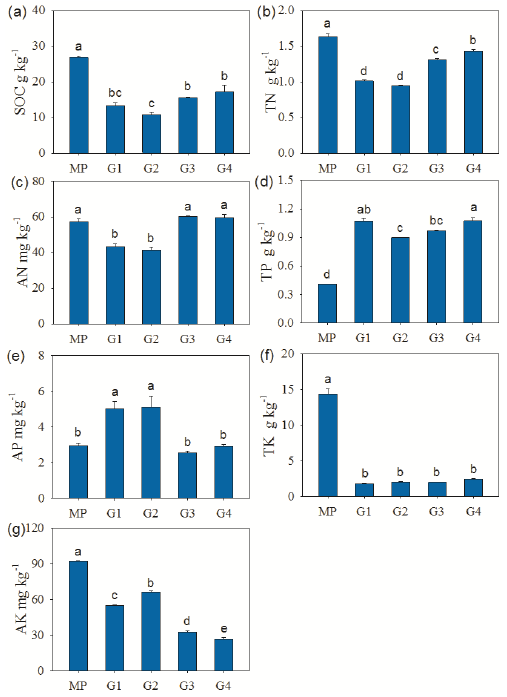
Figure 2. Soil chemical properties in the Pinus and the successive Eucalyptus plantations. MP, G1, G2, G3 and G4 refer to the Pinus plantation and the first, second, third and fourth generation Euca- lyptus plantations, respectively. SOC, soil organic carbon; TN, total nitrogen; TP, total phosphorus; TK, total potassium; AN, alkaline hydrolytic nitrogen; AP, available phosphorus and AK, available potassium. Soil chemical properties with the same letter are not sig- nificantly different at p <0.05.